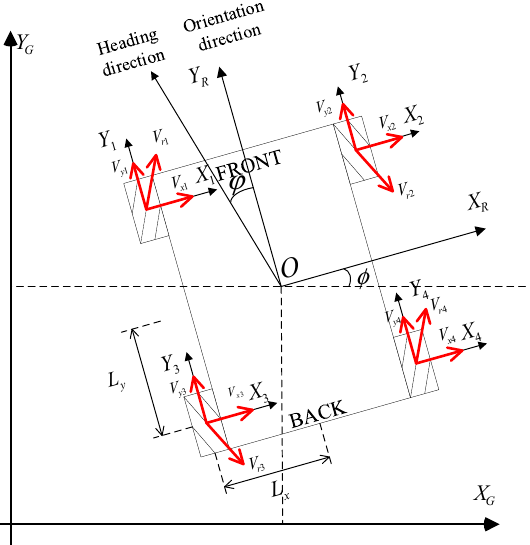
Figure 1. Schematic of the four-wheeled Mecanum wheel robot (FMWR).